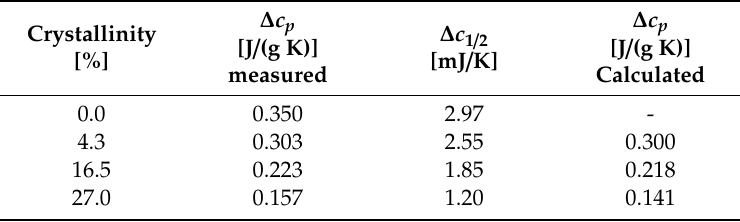
Figure A2. Curves of di ff erently crystallized poly(ethylene terephthalate) (PET). ( a ) DSC curves in the glass transition range including glass transition evaluation. ( b ) Derivative of the curves from the left diagram and integration of the left side of the peak to determine ∆ c 1 / 2 according to Equation (A1). Table A1. Glass transition intensity of di ff erently crystallized PET at 225 ◦ C. The measured ∆ c p is determined from Figure A2a. ∆ c 1 / 2 is determined by integration of the low-temperature side of the first derivative in Figure A2b. The calculated data are determined by Equation (A3).